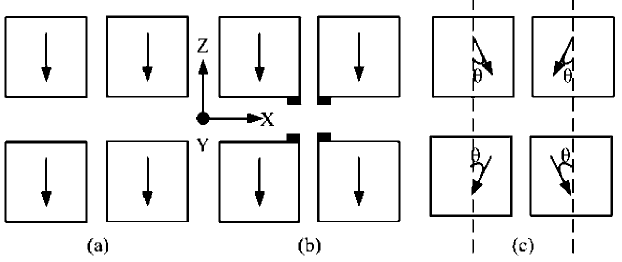
FIG. 4. Two algorithms to improve the homogeneity of the vertical field: (a) original concept without modification; (b) shim added at the magnet edge; (c) magnetization of the magnet block at an optimal angle.